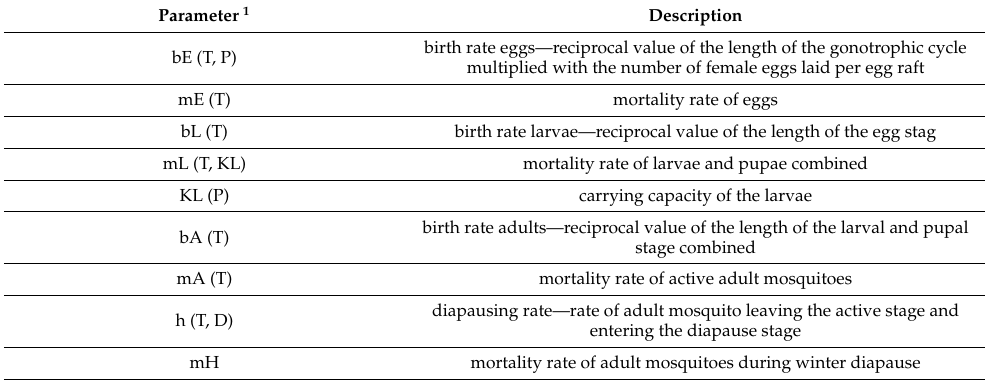
Figure 1. Block diagram of the Culex population model, incorporating 4 stages: E —eggs, L —larvae (inclusive pupal sage), A —active adults; H —hibernating adults. For definition of the parameters, see Table 1. Table 1. Definition of the transition parameters used in the Culex population model. Model parame- ters are per capita rates in units days − 1 .